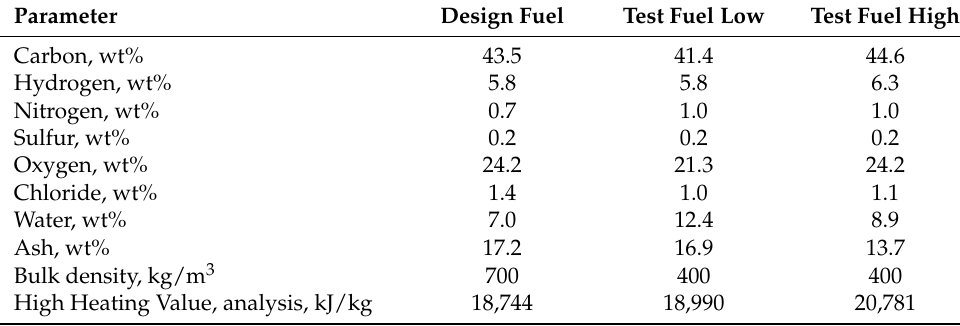
Table 2. Properties of the design and test